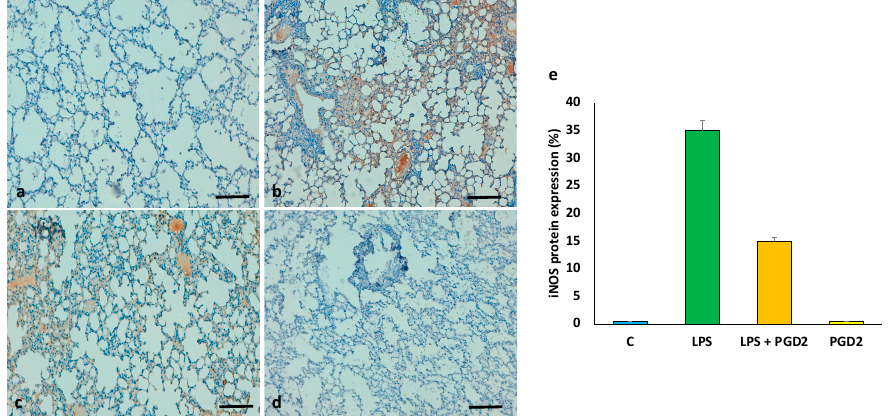
Figure 7. Expressional pattern of iNOS in different experimental mice models: ( a ) the control mice did not show any iNOS level; ( b ) in LPS-treated (5 mg/kg b.w.) animals, the expression of this enzyme was significantly high; ( c ) in treatment group animals (LPS + PGD 2 ), the expression of this protein was decreased; ( d ) in PGD 2 (100 µ g/kg b.w.) only treatment animals, no expression of iNOS protein was observed; ( e ) iNOS percent expression pattern in different groups. (Scale bar = 100 µ m).